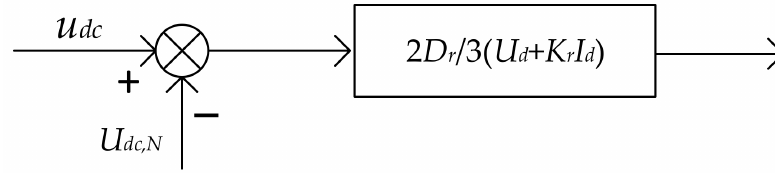
Figure 5. Voltage damping M r control block